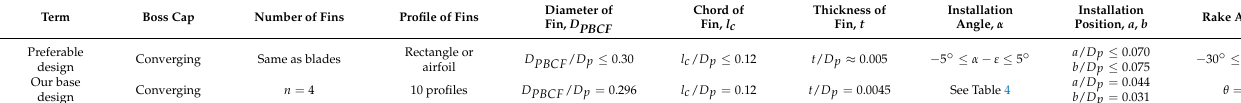
Table 5. Preferable design of PBCFs recommended in the literature vs. Our base design of the PBCFs.